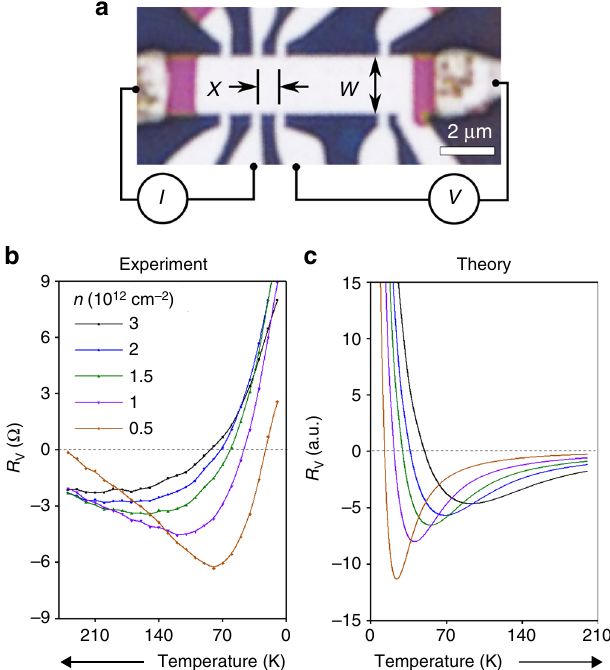
Fig. 1 Vicinity resistance R v . a Optical photograph of one of our devices on which the measurement geometry is indicated: current I is injected into the graphene channel through a 300 nm contact and the voltage drop is measured at a distance x from the injection point. Device width W is 2.3 μ m. b , c Temperature dependence of the vicinity resistance measured experimentally and computed theoretically for different carrier densities n in bilayer graphene. The most negative value occurs at the fl uidity onset, Kn (cid:3) 1, where Kn is the Knudsen number,